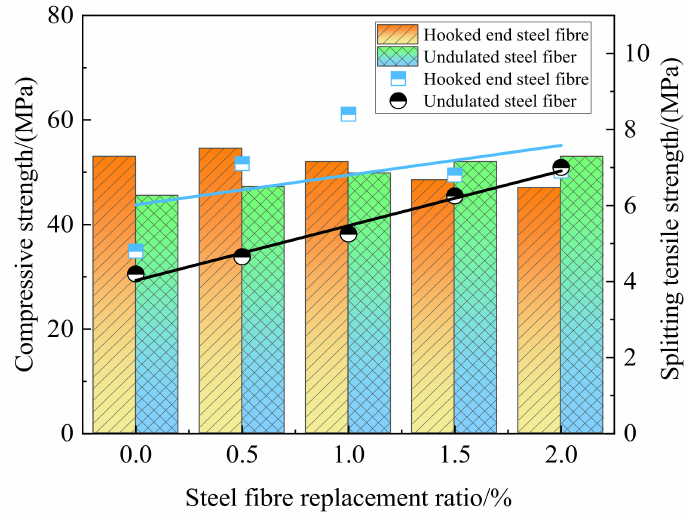
Figure 22. Strength of aggregate concrete mixed with gangue of different amounts of steel fiber [102,105].